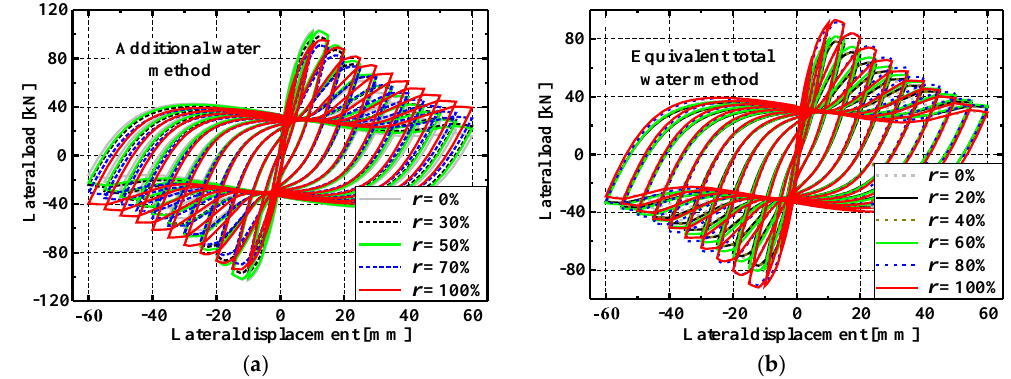
Figure 8. Effect of RCA percentage on hysteresis loops of RRC columns ( n = 0.3). ( a ) Additional water method (Xiao et al. [56]). ( b ) Equivalent total water method (Chen et al. [72]).